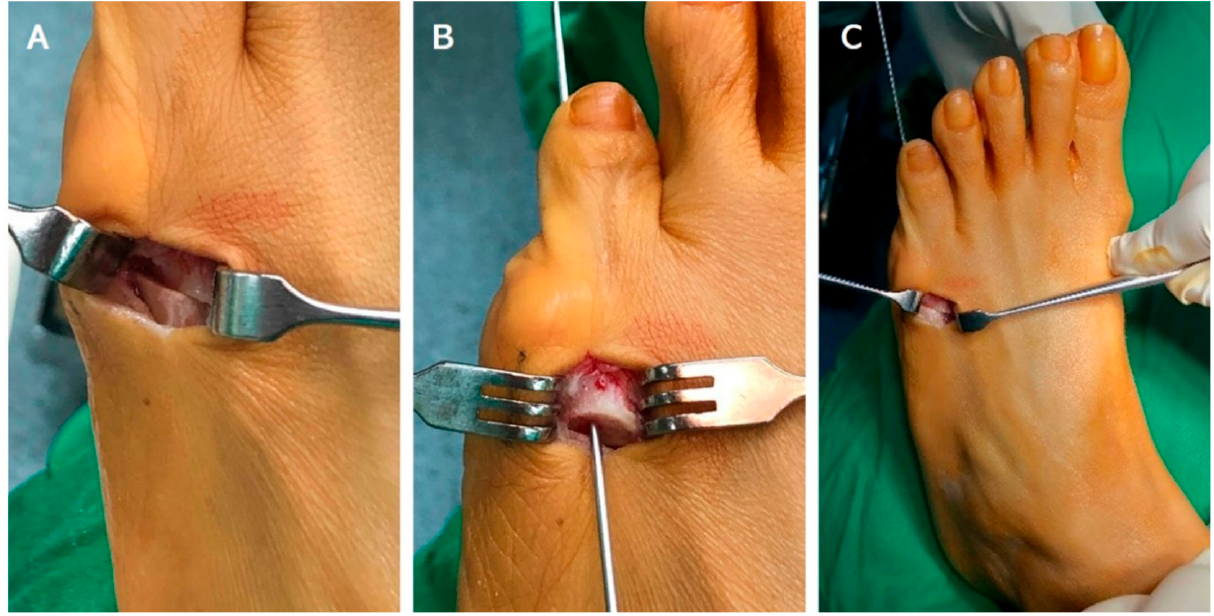
Figure 1. ( A ) Sliding oblique osteotomy was performed on level of 5th metatarsal neck with proper medialization. ( B ) Antegradely reamed 1.5 mm Kirschner through medullary canal to the tip of 5th toe and pull out from the tip for enough length further fixation. ( C ) Fixation was done with retro- gradely reamed 1.5 mm Kirschner wire after sliding medialization.